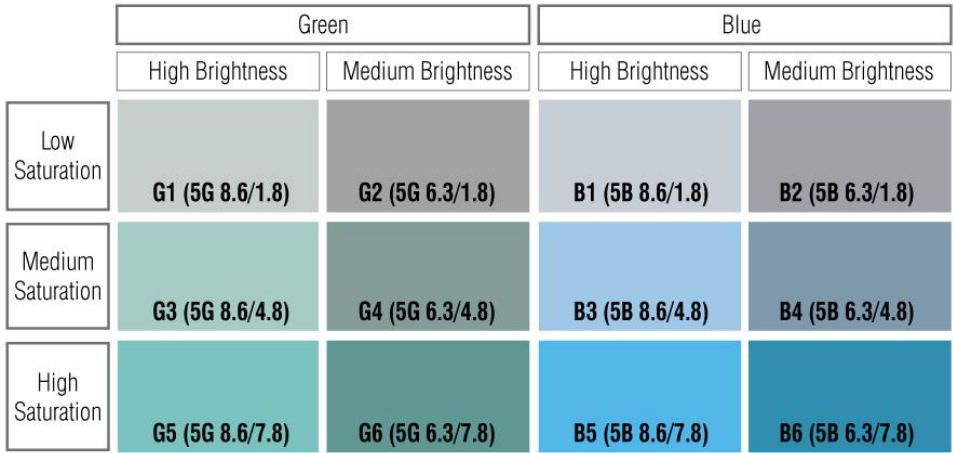
Figure 1. 12 Color samples used for the experiment on the HRV